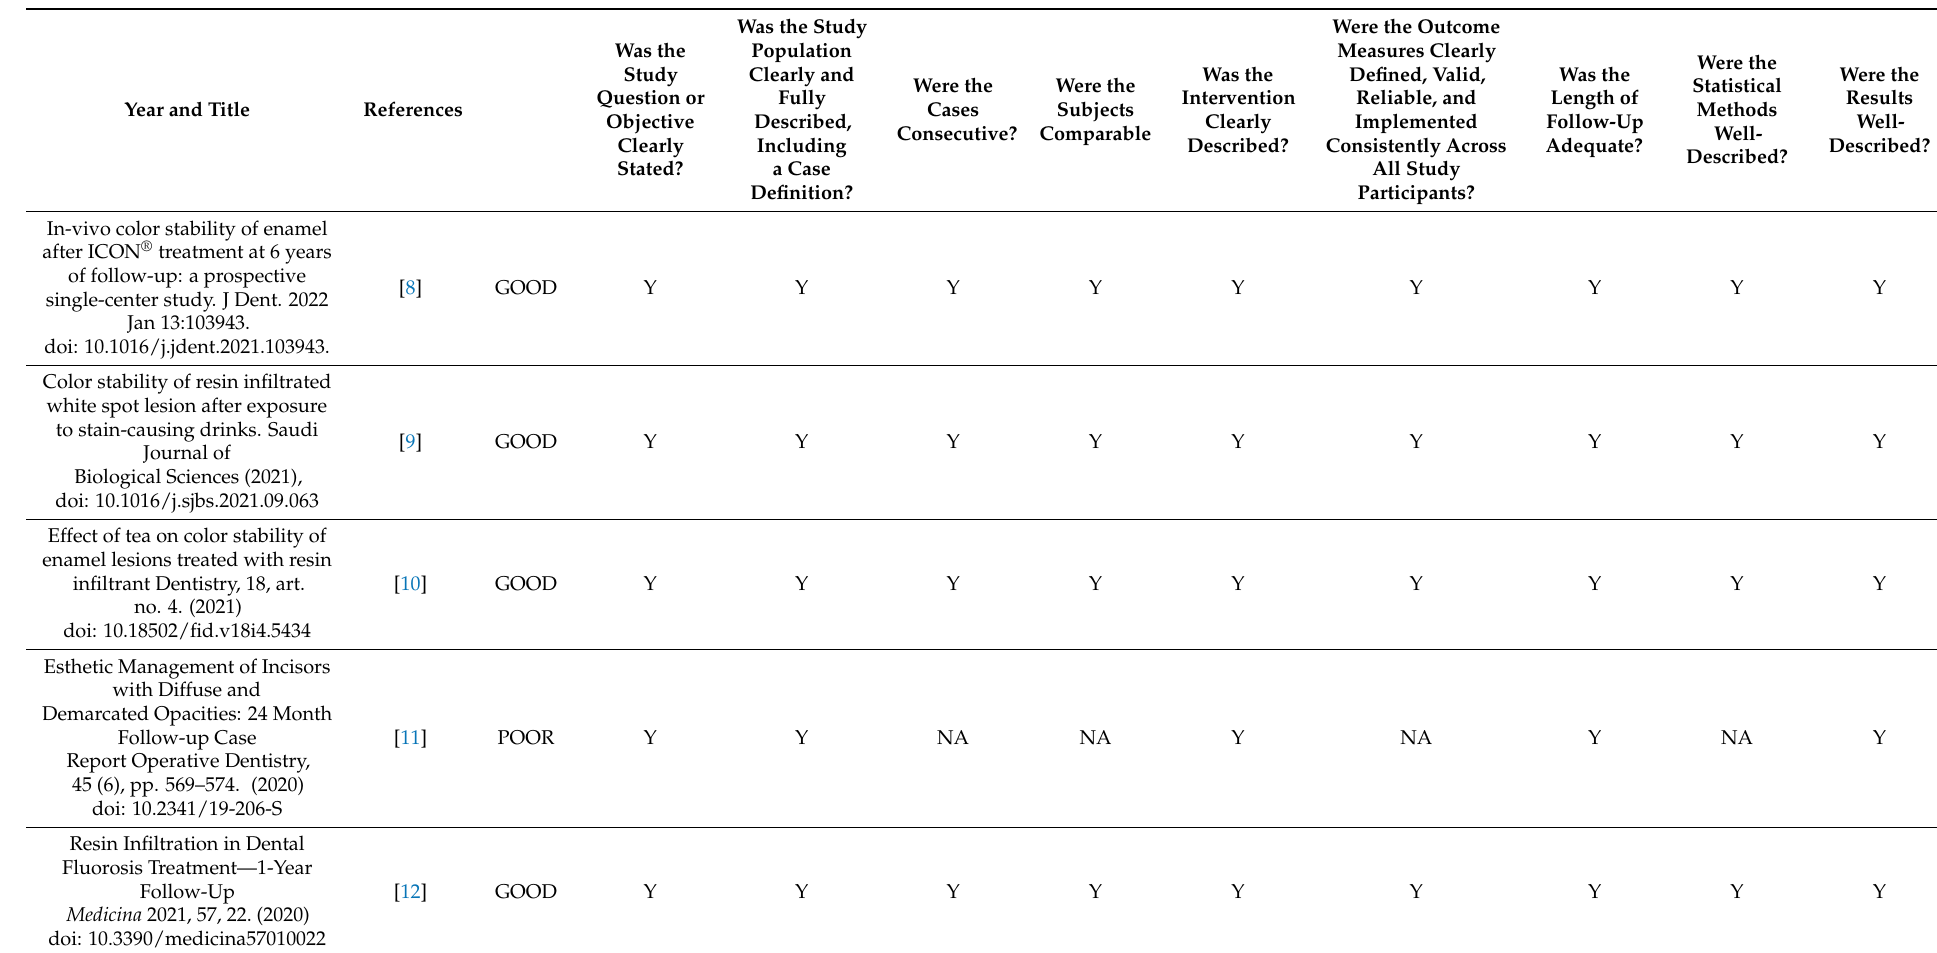
Table 1. Study quality assessment. CD, cannot determine; NA, not applicable; NR, not reported; Y, yes; N,